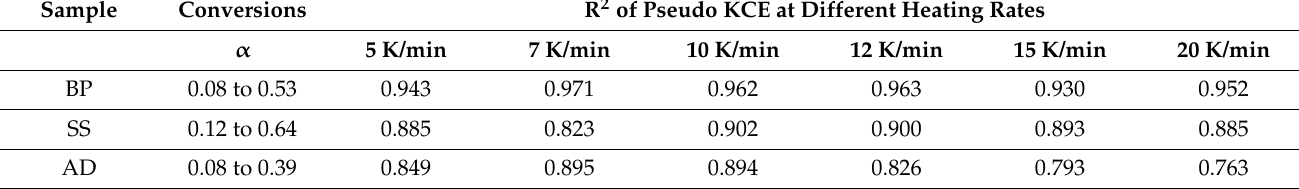
Table 2. Linear relationship (pseudo KCE) between ln A and